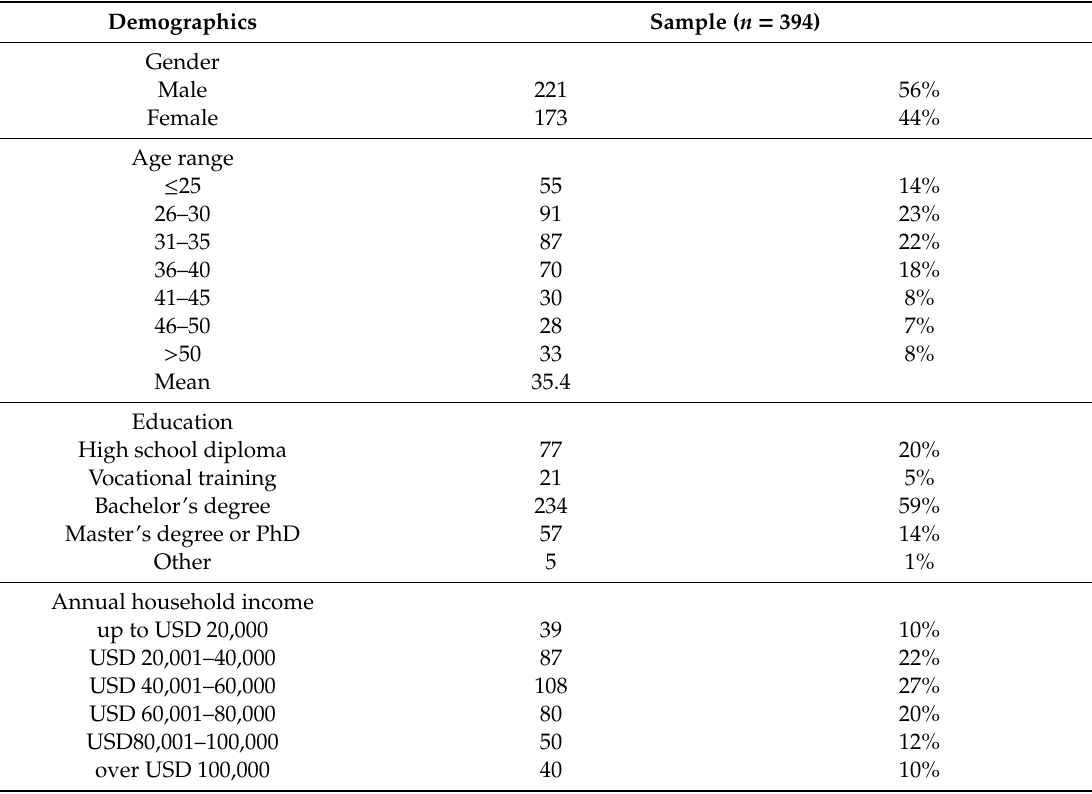
Table 1. Sample descriptive